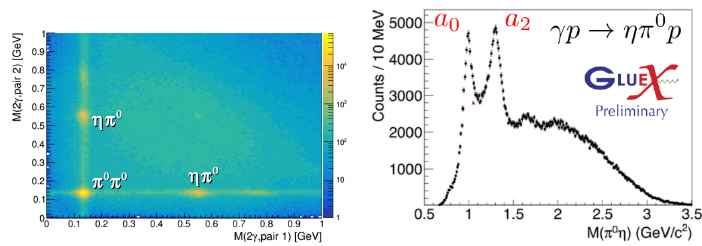
Figure 4: (Left) The two-dimensional plot of the invariant mass of one set of γγ versus the other set of γγ from γ p → γγγγ p . Clearly visible are signals for both ηπ 0 and π 0 π 0 . (Right) The invariant mass of π 0 η showing a prominent a 0 (980) and a 2 (1320).